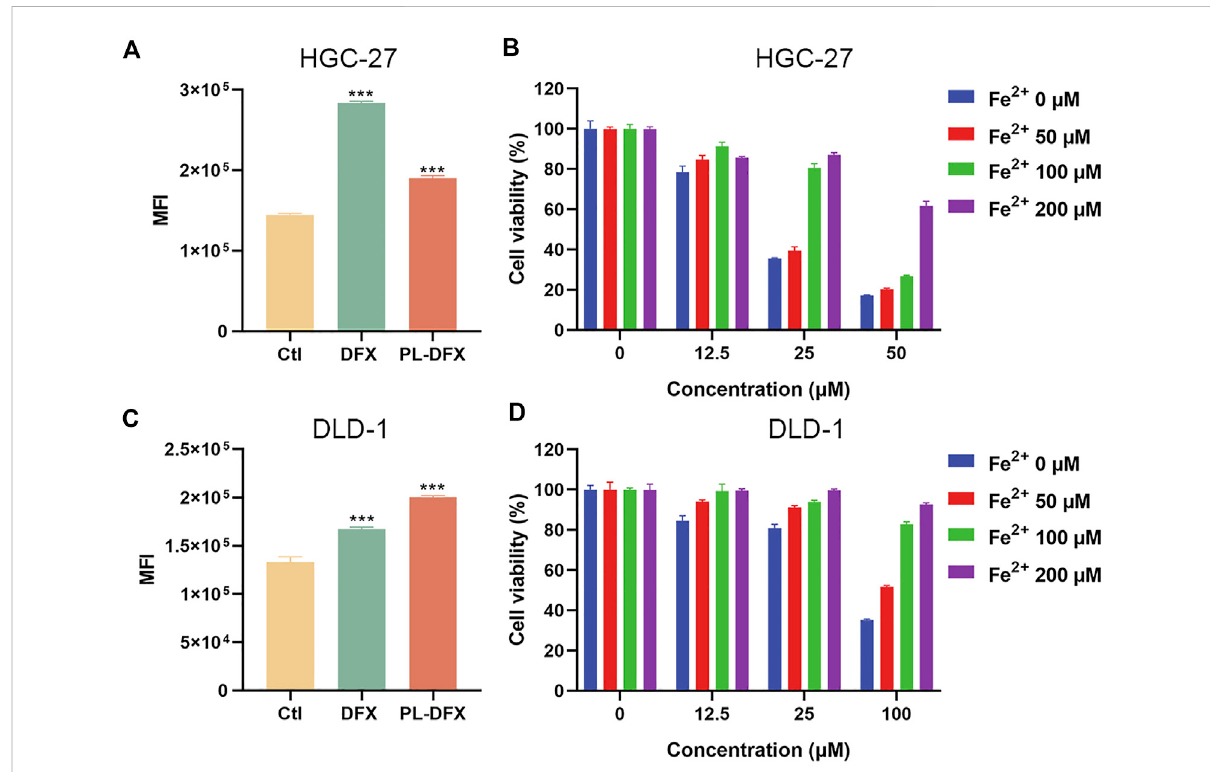
Disruption of cellular iron metabolism. (A,C) Flow cytometric analysis of intracellular iron of HGC-27 and DLD-1 using calcein-AM after treatment withDFX(25 μ M)andPL-DFX(12.5 μ M)for 48 h (B,D) CellviabilitiesofHGC-27andDLD-1aftertreatmentwithPL-DFX inthepresenceor absence of Fe 2+ for 48